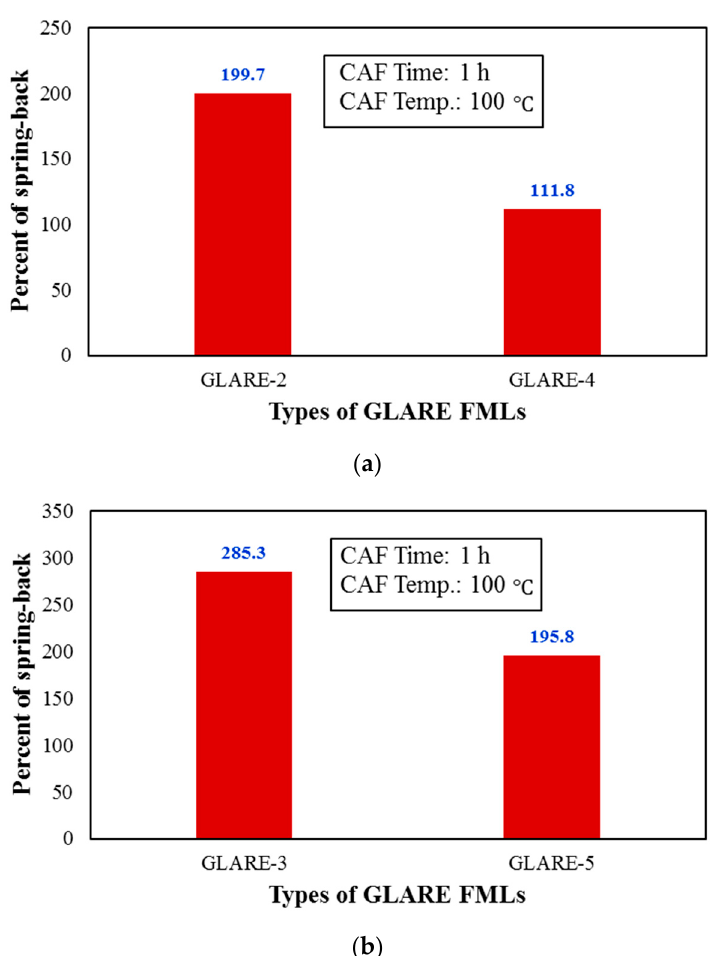
Figure 8. Effect of stacking sequence of composites layer on the springback behavior of ( a ) GLARE-2 and GLARE-4 ( b ) GLARE-3 and GLARE-5